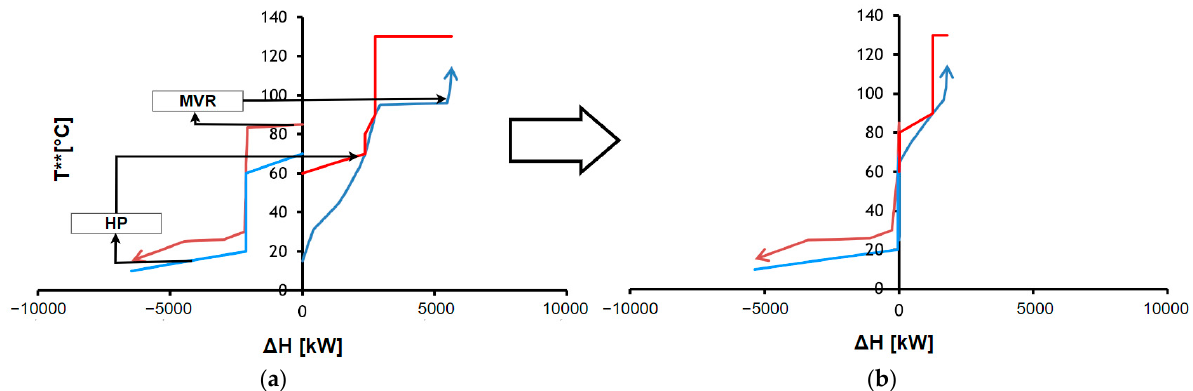
Figure 10. Total site integration plots showing potential heat pump installations ( a ), leading to final expected total site plot ( b ). The red colored lines on the Gross cold utility use side of the plot represent process streams that require cooling, and the blue colored lines represent the cold utility streams that would be required to carry out this cooling. The blue colored lines on the Gross hot utility use side of the plot represent process streams that require heating, and the red colored lines represent the hot utility streams that would be required to carry out this heating.